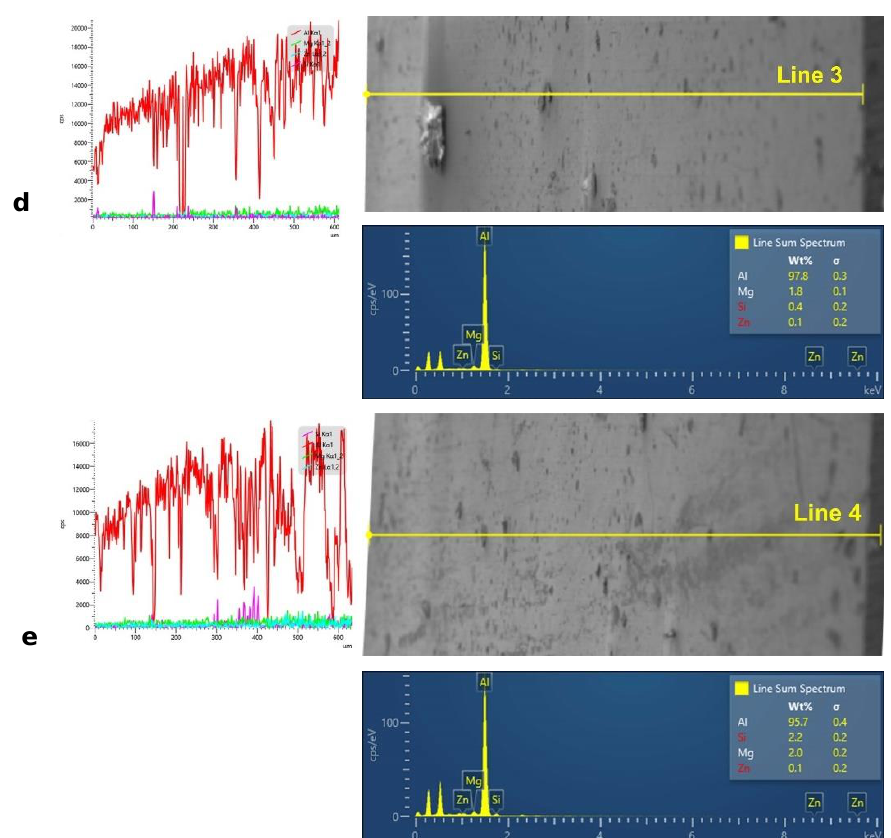
Fig. 4. Line elemental map of the ARB Composite